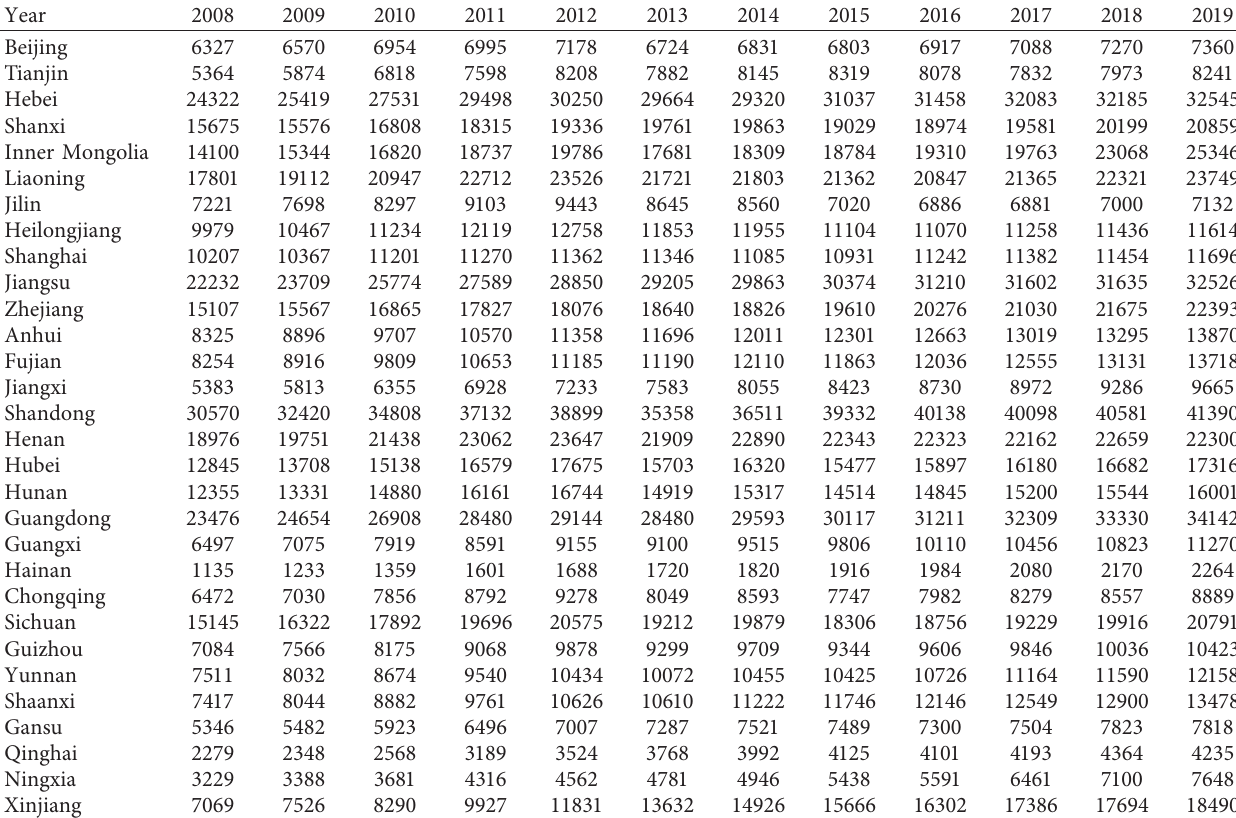
Table 3: Energy consumption data of 30 provinces and cities in China (standard coal: 10,000